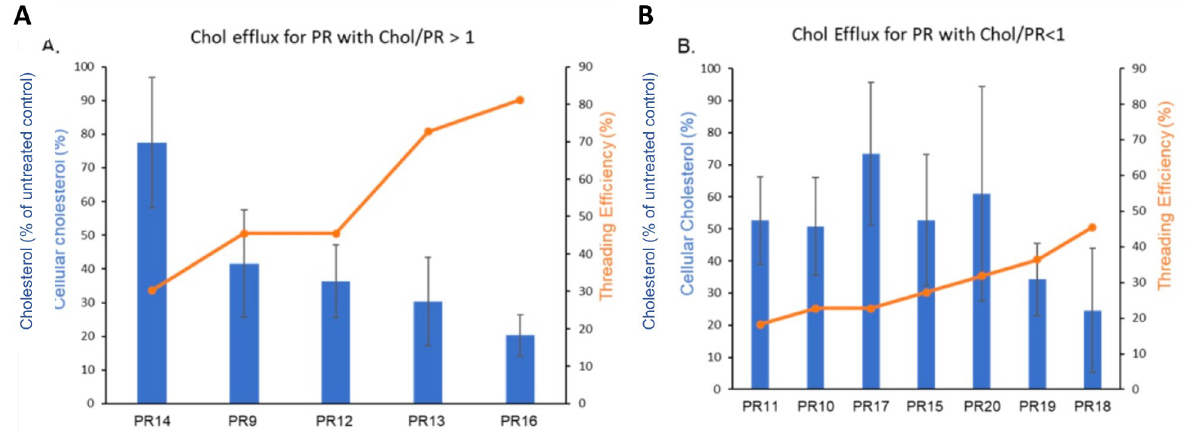
Fig 2. Cholesterol mobilization as a function of polyrotaxane threading efficiency in NPC1 deficient cells. A. Cellular cholesterol content as a function of polyrotaxanes with Chol/PR > 1. B. Cellular cholesterol content as a function of polyrotaxanes with Chol/PR < 1. Endo-lysosomal cholesterol staining is shown relative to untreated cells